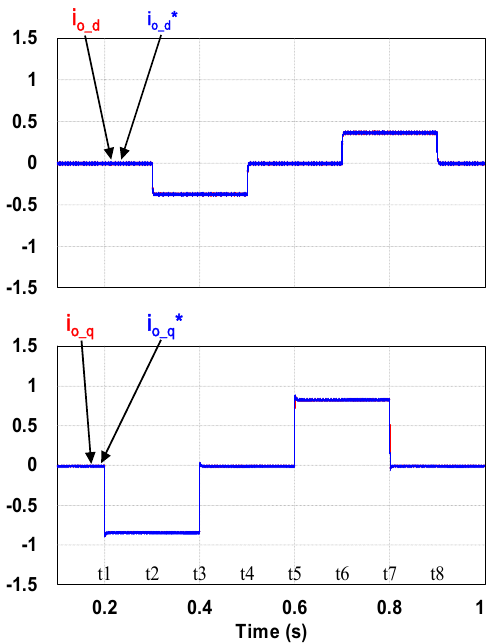
Figure 22. Waveforms of control commands and feedbacks: qd-axis inductor currents.